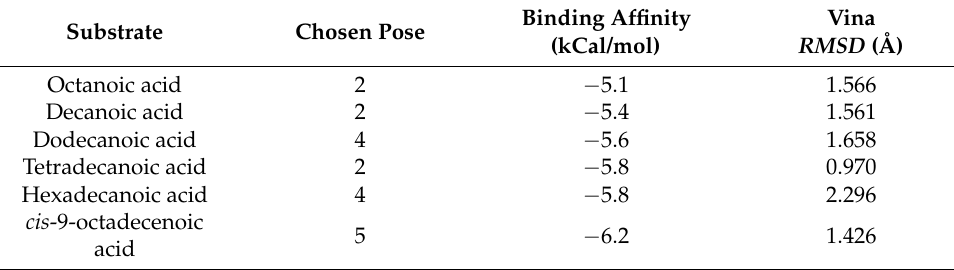
Figure 2. Results of structural verification of Eversa ® lipase by Verify 3D. Table 4. Results obtained in the molecular docking